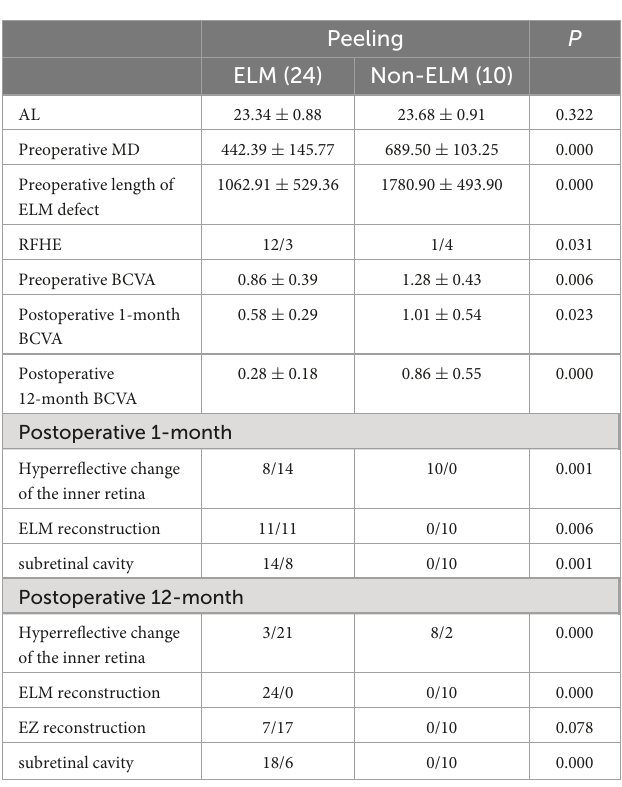
TABLE 6 Comparison of the preoperative and postoperative anatomical structures and visual function of the ELM and non-ELM groups in the peeling